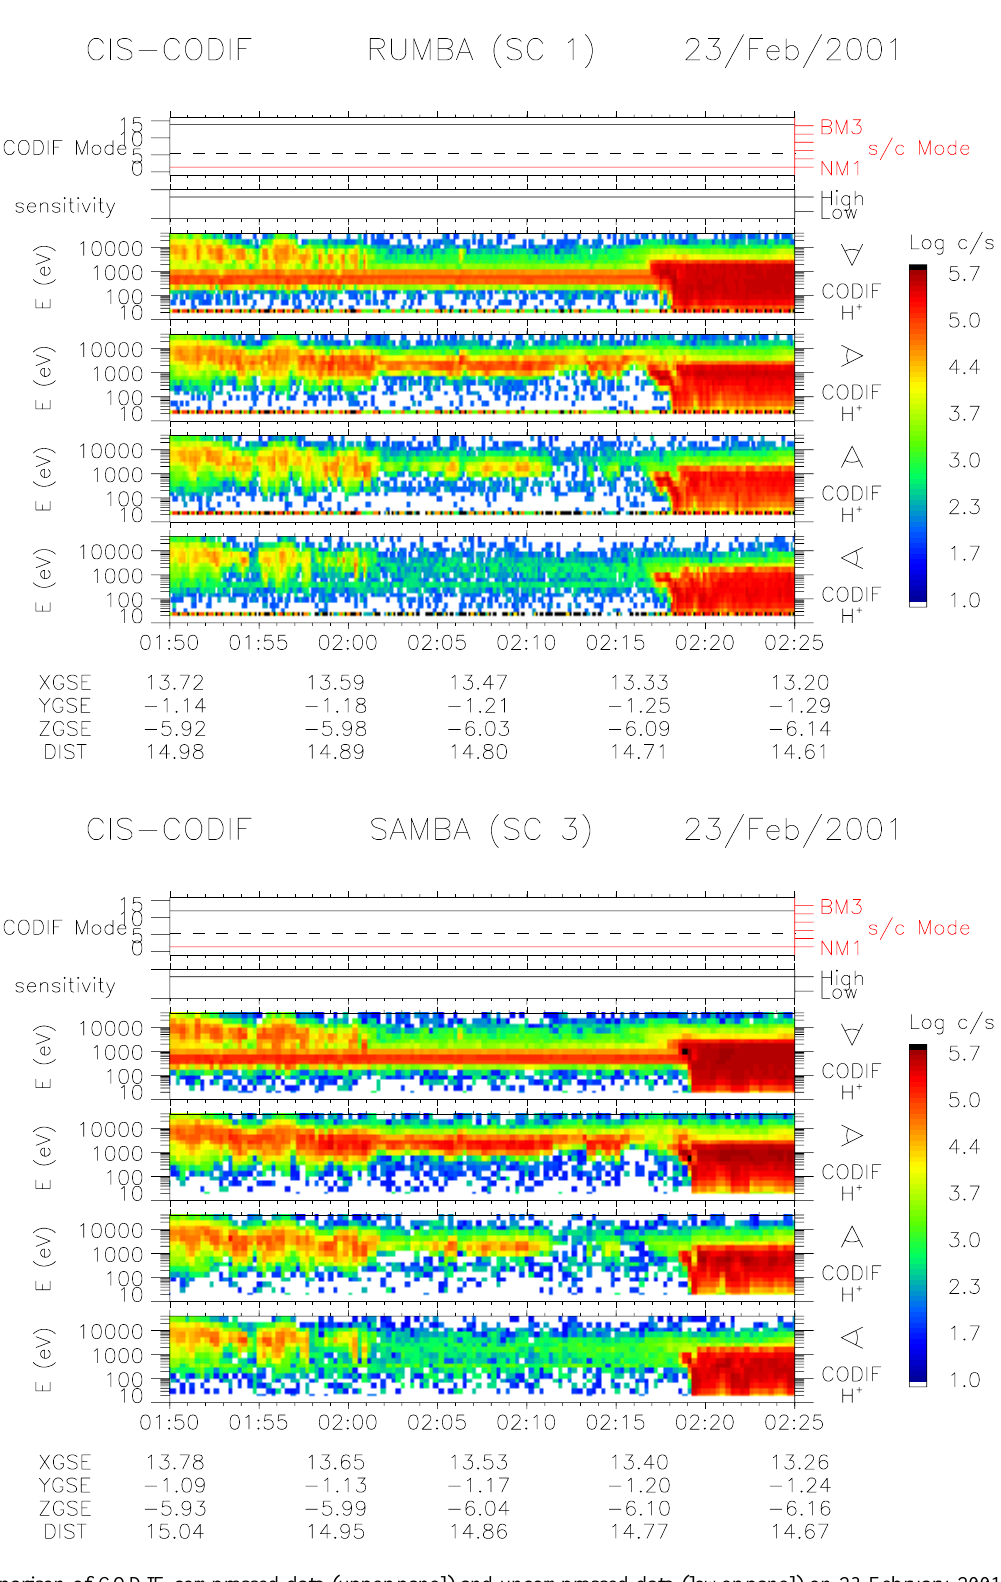
Fig. 20. Comparison of CODIF compressed data (upper panel) and uncompressed data (lower panel) on 23 February 2001: upper panel gives for spacecraft 1, from top to bottom, the telemetry modes, sensitivity and uncompressed energy-time spectrogram H + CODIF in four directions (top to bottom: sunward, dusk, anti-sunward and dawn CODIF measurements). Lower panel gives the same results for spacecraft 3 with compressed counting